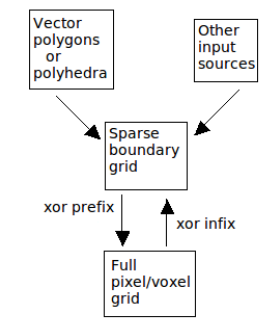
Fig. 1 Flowchart of the method